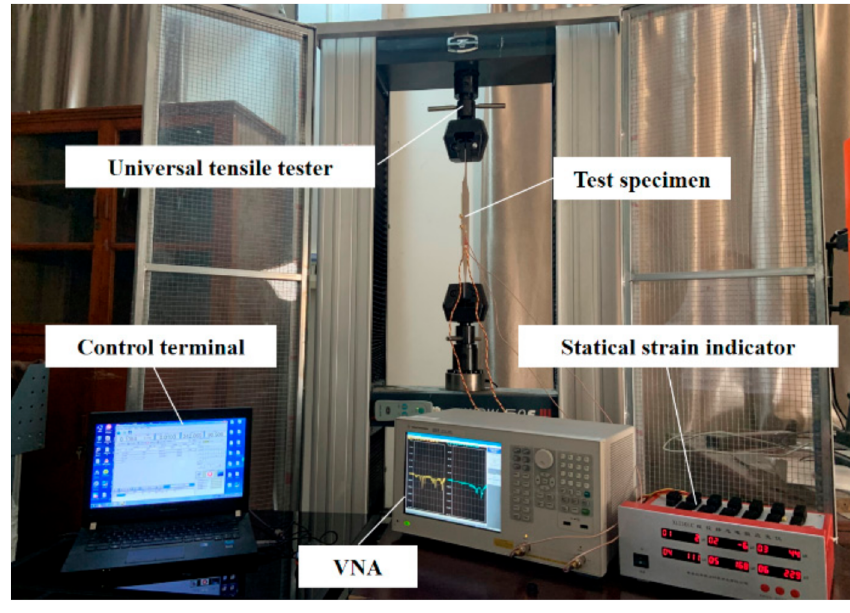
Figure 14. Test device.